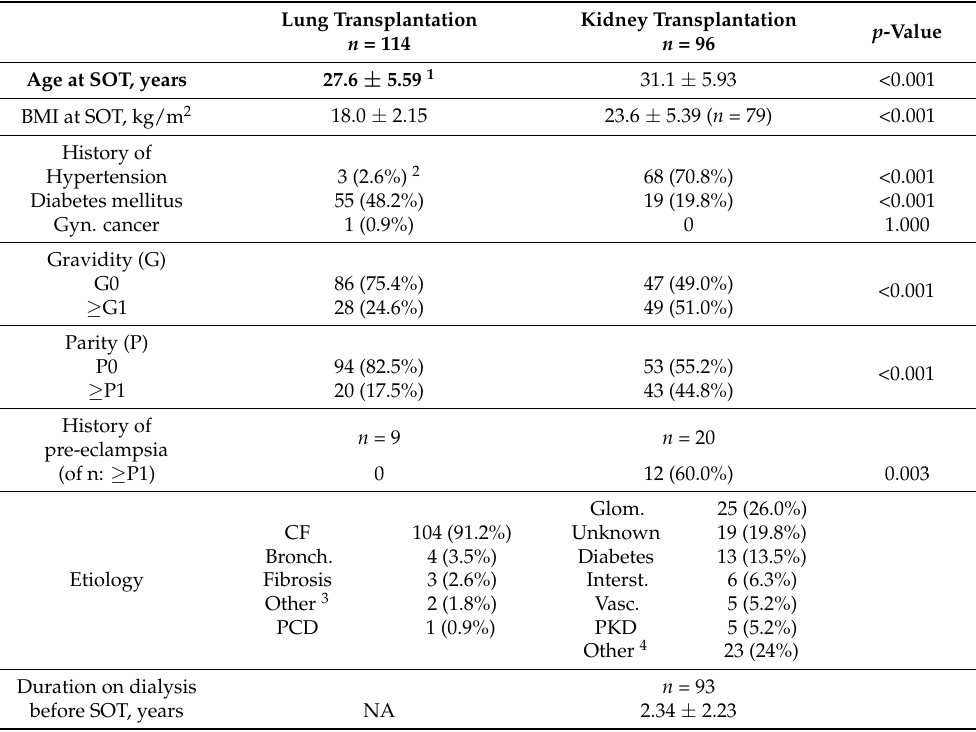
Table 1. Demographic and medical histories of patients before